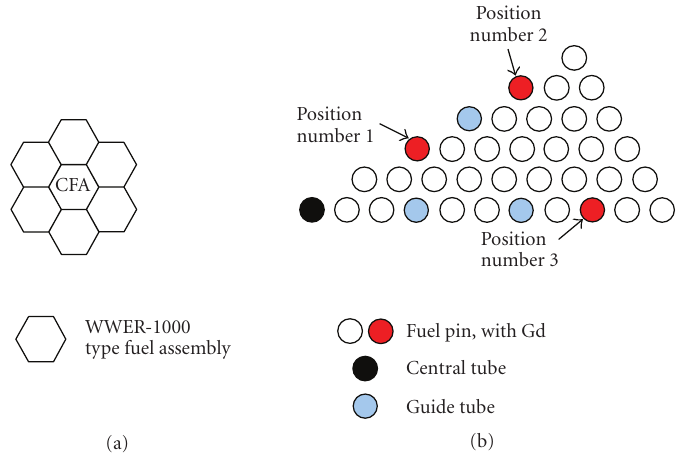
Figure 1: (a) Schematic arrangement of the LR-0 reactor core containing 7 WWER-1000 type-FAs with central FA (CFA) for Gd FP influence investigation and (b) the 30-degree symmetry sector of the CFA with 3Gd